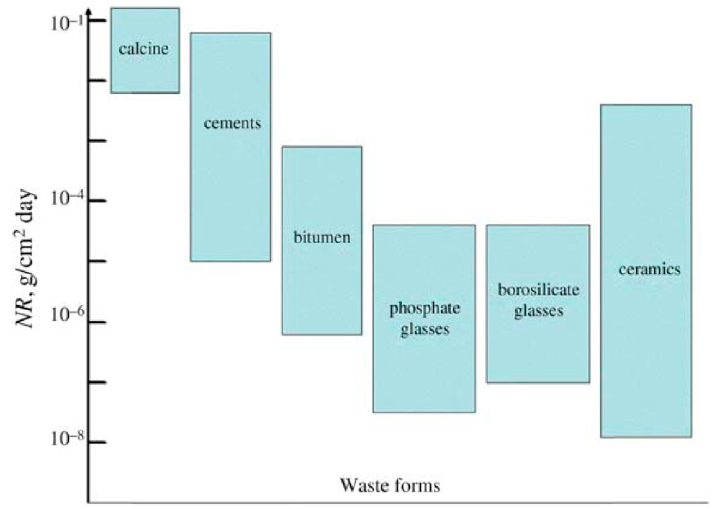
Figure 1. Normalized leaching rates of various wasteforms (after Reference [1]).